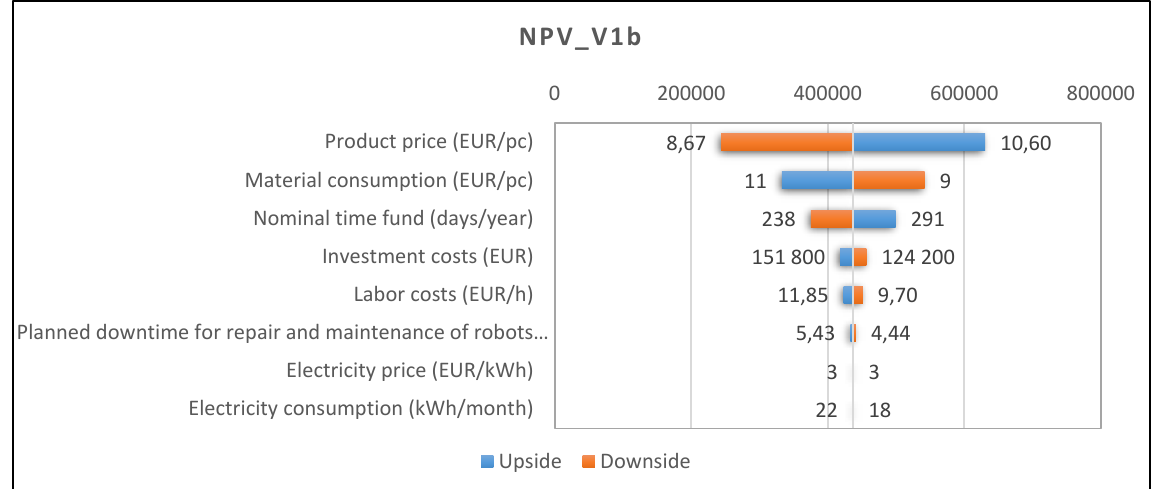
14 of 18 Figure 10. Graph of sensitivity of risk factors to NPV_V1b. The tornado chart (see Figure 11) shows the strengths of the individual influences of the input variables on the change in the financial criterion NPV_V1b. It shows the varia-